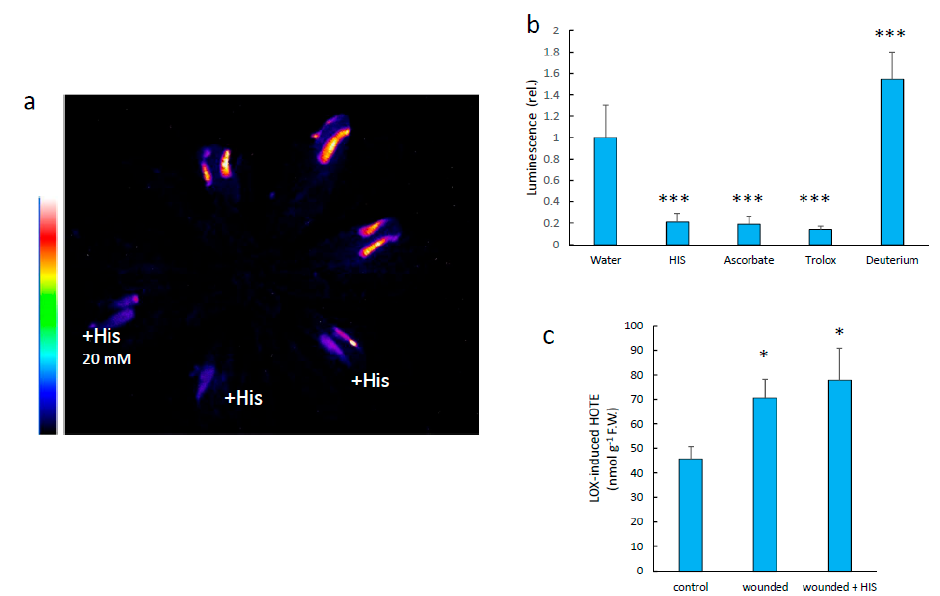
Figure 8. Effect of singlet oxygen quenchers on the intensity of Arabidopsis leaf SCL. ( a ) SCL image of an Arabidopsis plant with wounded leaves and the effect of several singlet oxygen quenchers (His, Trolox, ascorbate). ( b ) quantification of leaf SCL under the conditions shown in panel ( a ). ( c ) HOTE levels in control and wounded leaves treated or not with His. ***, significantly different from water at p < 0.001; *, significantly different from control at p < 0.01 (Student’s t -test).